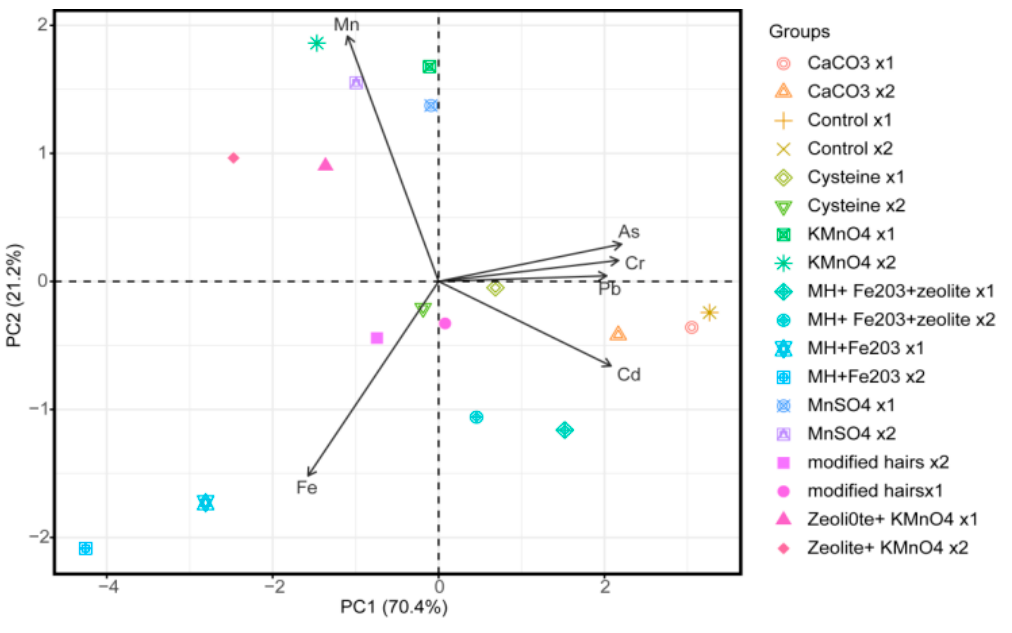
Figure 2. Principal component analysis of total element’s concentration in soil. PC: Principal Components.